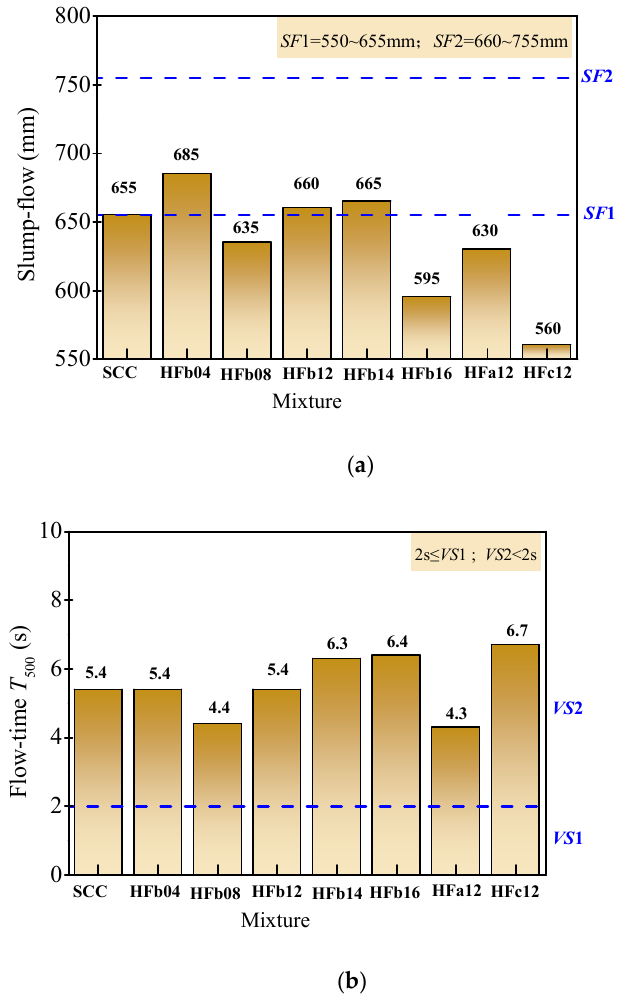
Figure 4. Filling ability evaluated by slump-flow and flow time. ( a ) Slump-flow. ( b ) Flow time T 500 .